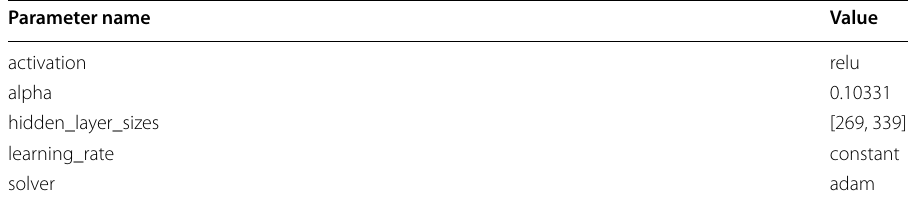
Table 109 Modes of MLP tuned hyperparameter values for experiments with the keylogging dataset